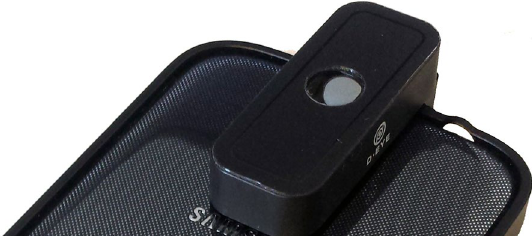
Figure 1. Galaxy S4 equipped with the D-Eye adapter. The D-Eye adapter is magnetically attached to a frame that encompasses the Galaxy